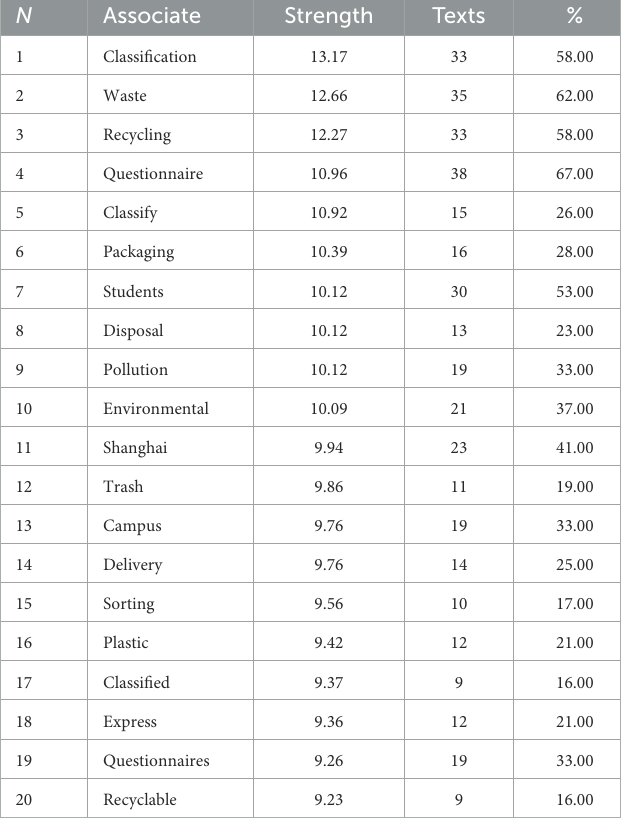
TABLE 3 Top 20 associates of garbage